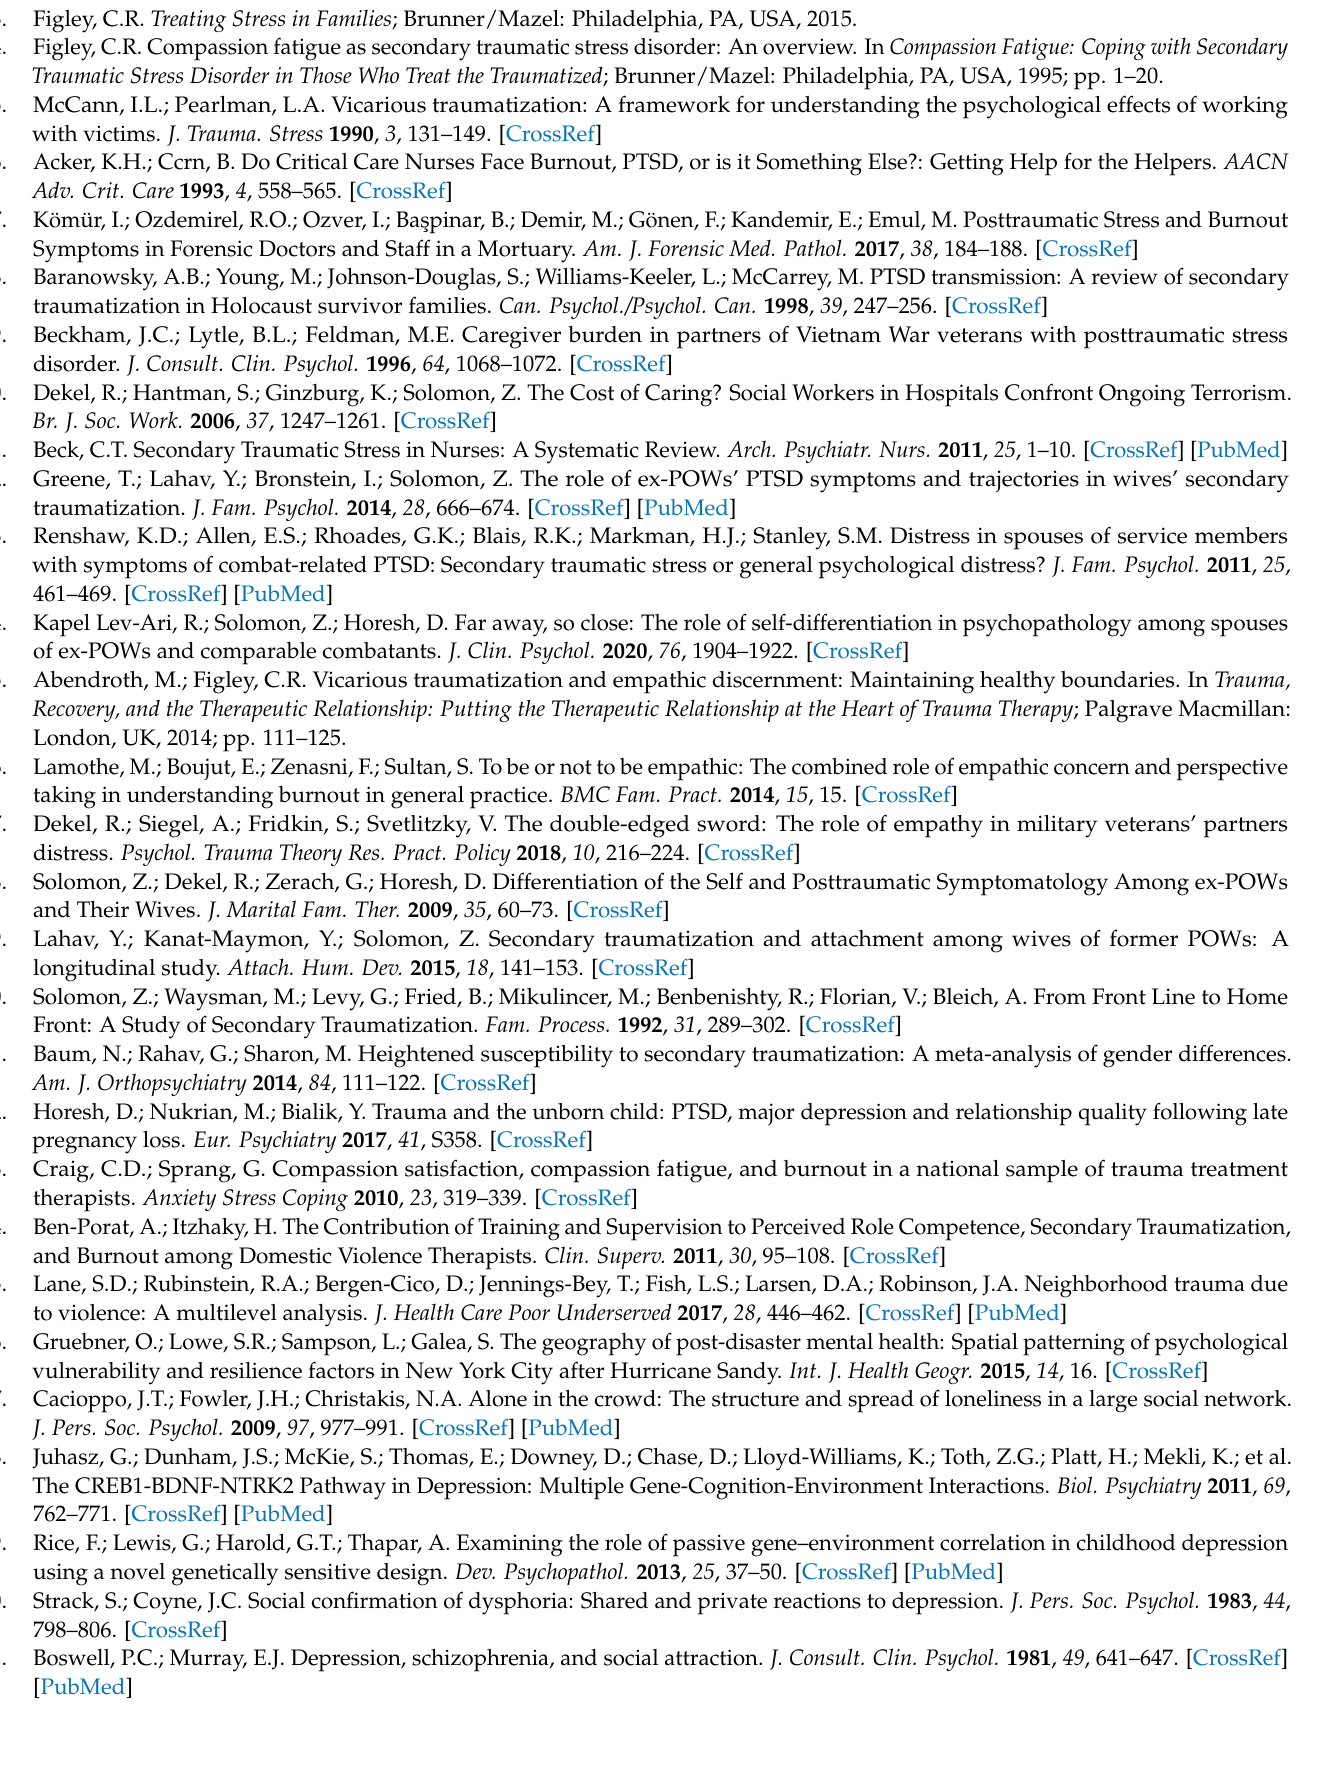
Figley, C.R. Treating Stress in Families ; Brunner/Mazel: Philadelphia, PA, USA, 2015. 34. Figley, C.R. Compassion fatigue as secondary traumatic stress disorder: An overview. In Compassion Fatigue: Coping with